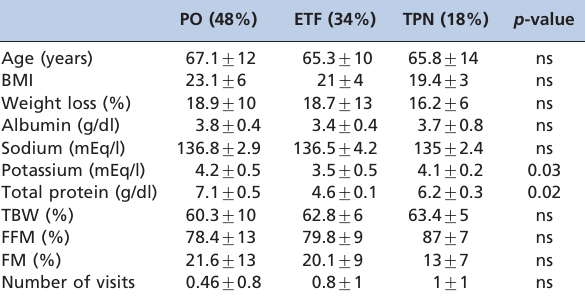
Table 2 - Characteristics of the population according to the route of nutrient